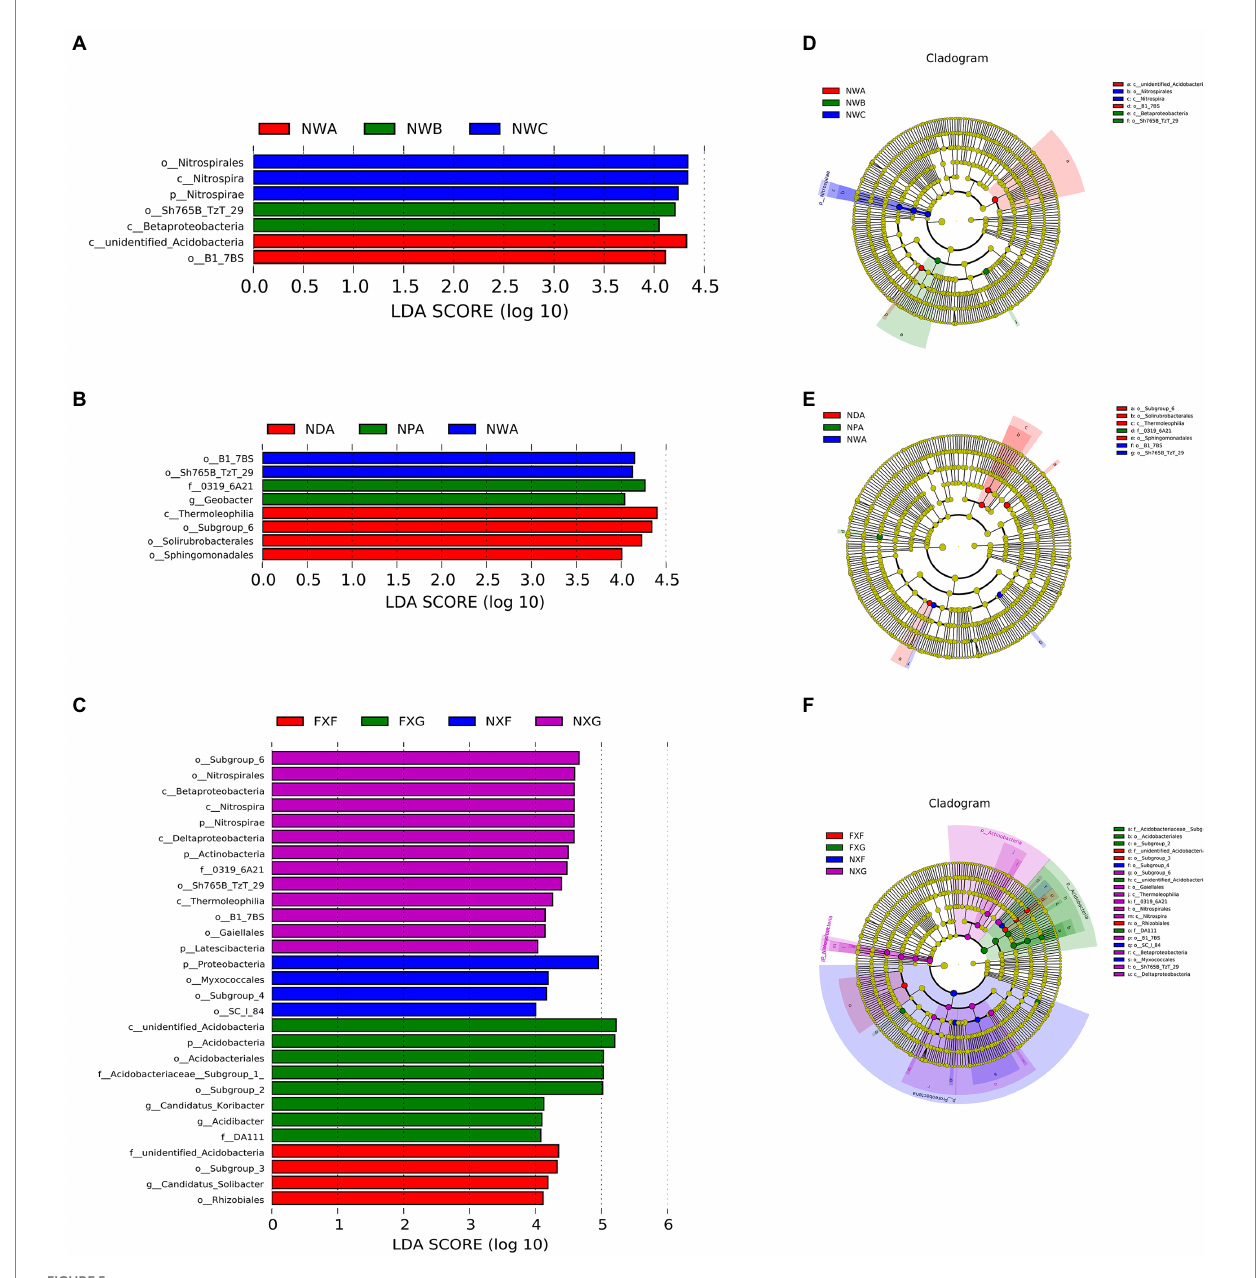
FIGURE 5 LDA value distribution histogram and evolutionary branches of LEfSe analysis. In the evolutionary cladogram, circles from inside to outside represented the classification level from the phylum to the species. Coloring principle: Species without great differences were uniformly colored yellow, and the Biomarker followed the group for coloration. The red node indicated that the microbial group played a significant role in the red group, and the green node indicated that the microbial group played a significant role in the green group. The blue node indicated that the microbial group played a significant role in the blue group, and the purple node indicated that the microbial group played a significant role in the purple group. (A) : LDA value distribution histogram of NWA, NWB, and NWC groups; (B) : LDA value distribution histogram of NDA, NPA, and NWA groups; (C) : LDA value distribution histogram of FXF, FXG, NXF, and NXG groups; (D) : Evolutionary cladogram of NWA, NWB, and NWC groups; (E) : Evolutionary cladogram of NDA, NPA, and NWA groups; (F) : Evolutionary cladogram of FXF, FXG, NXF, and NXG